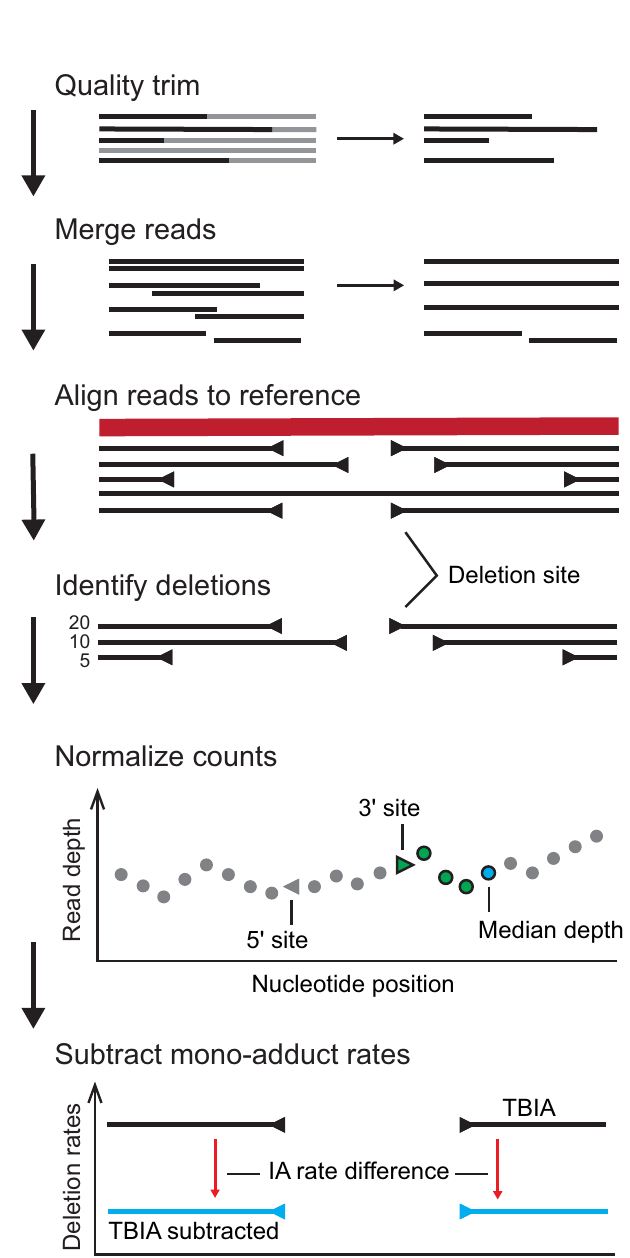
Fig 2. ShapeJumper overview. SHAPE-JuMP sequencing reads are processed for read quality, and paired reads (if used) are merged. Reads are aligned to a reference sequence, creating an initial set of candidate deletion sites. Candidate deletion sites are either identified from an alignment directly or inferred from two alignments separated by unaligned reference sequence. Deletion rates are normalized by the median read depth over the 5 nucleotides downstream of the 3’ deletion site. Normalized rates are obtained by subtracting mono- or no-adduct rates.